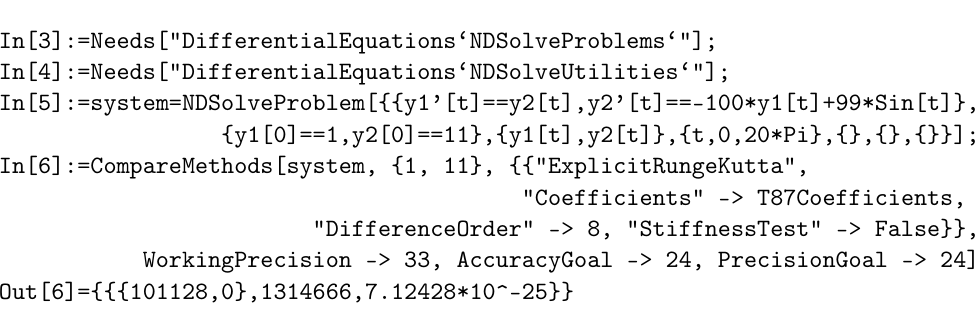
Figure 1. Efficiency plots for the inhomogeneous